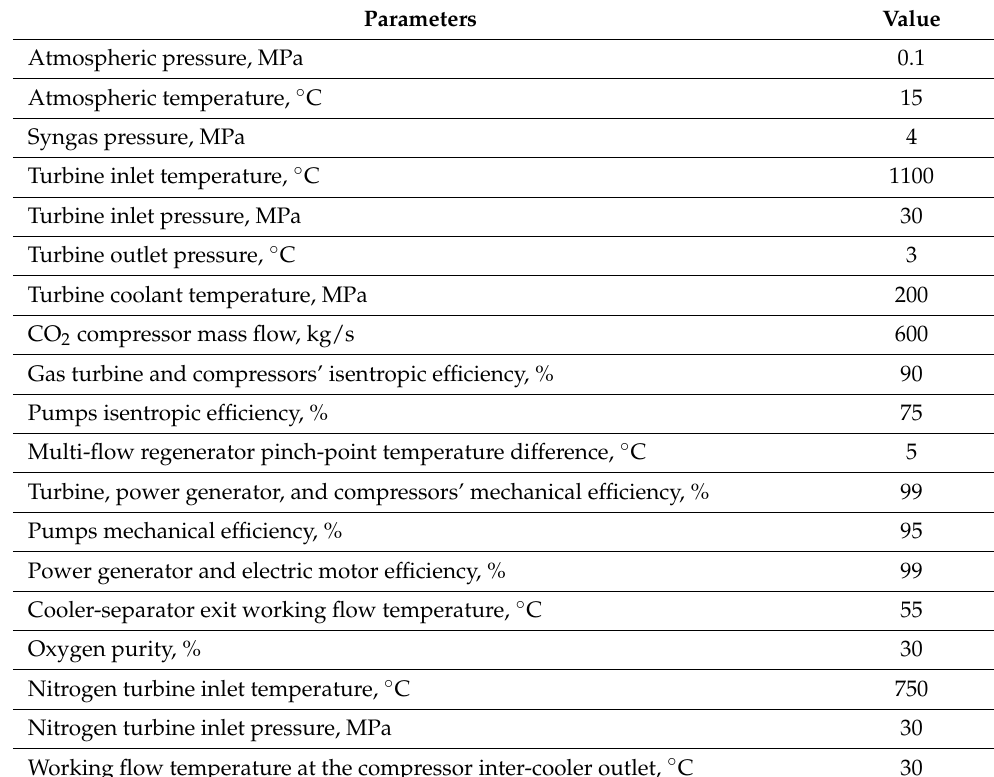
Table 2. Initial data for